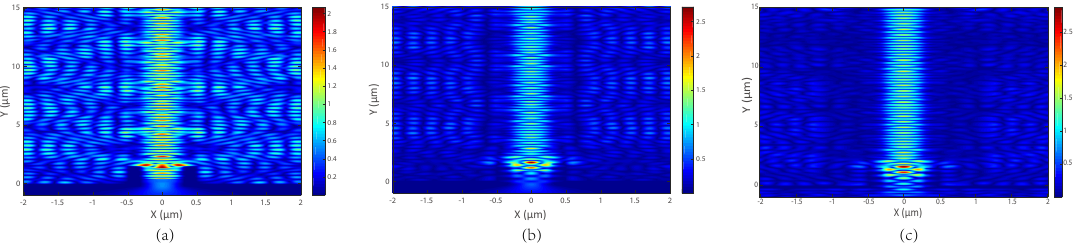
Figure 5. The E fields of waveguides with different column numbers of air holes without metallic sidewall (( a – c ) for 1.0,2.0,3.0 columns, respectively) at the wavelength of 1.55 µ